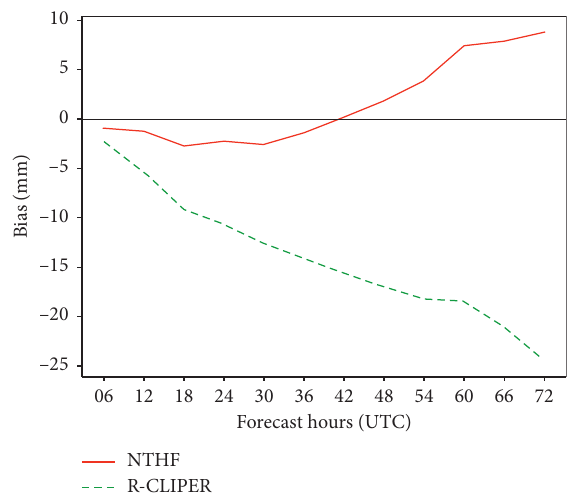
Figure 9: Time evolution of bias for mean rainfall. Bias, calculated as the difference between the mean rainfall predicted by NTHF (red line) and R-CLIPER (green line) and TRMM measurements, as a function of forecast hour.